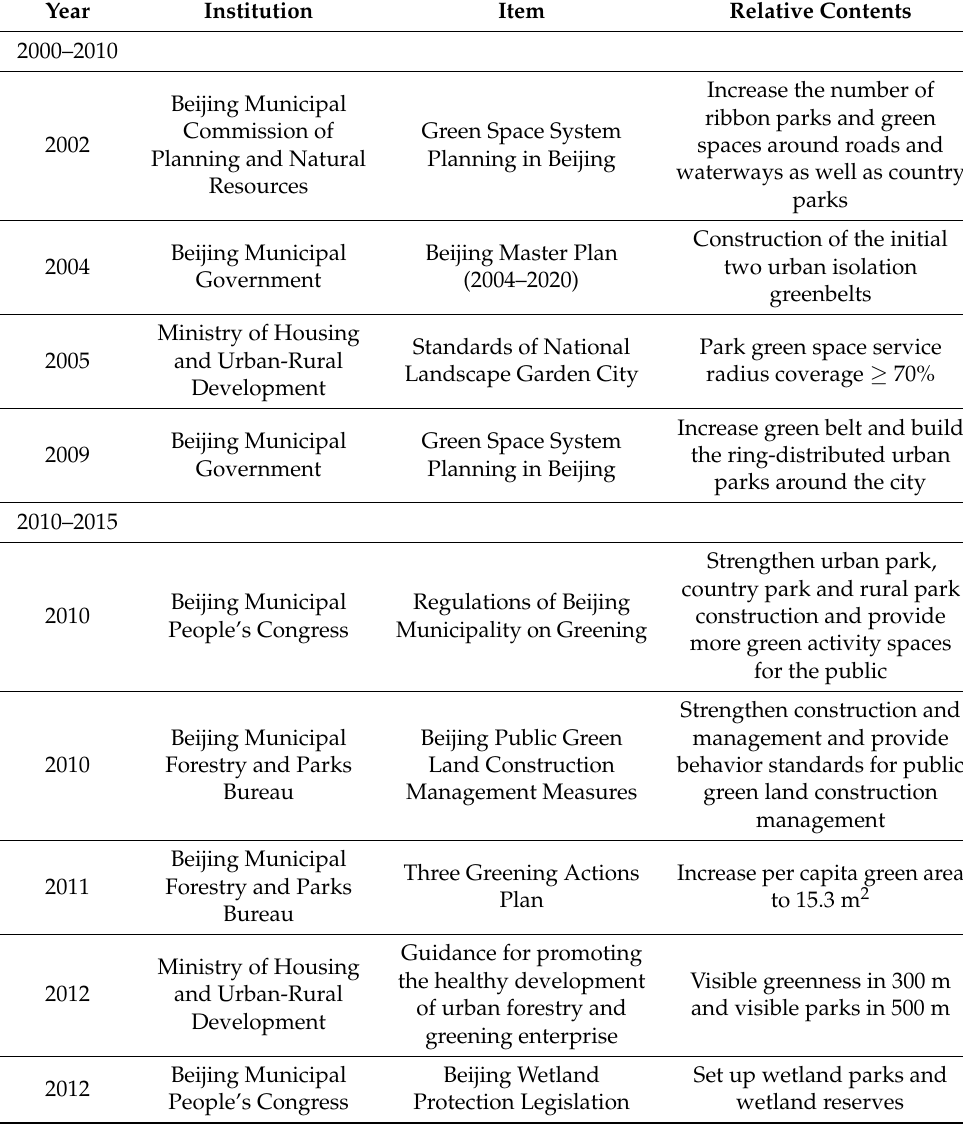
Table 2. Policies and regulations of urban forest construction in